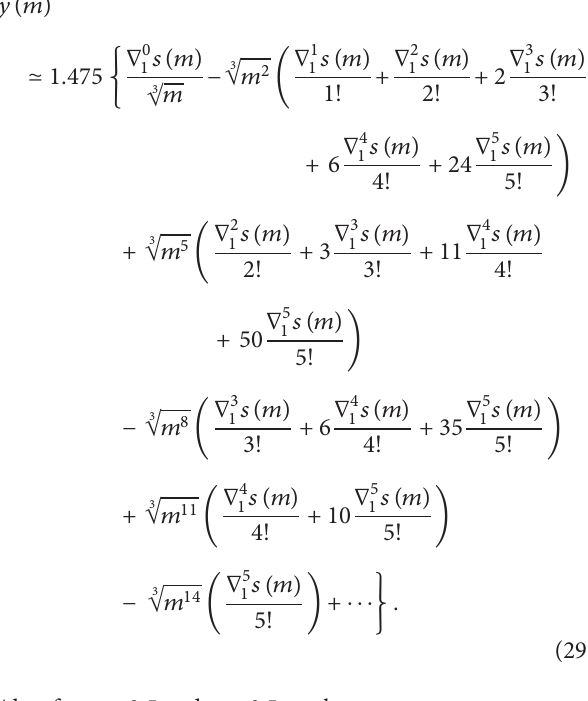
Figure 2: The outcome of the fractional signal when 𝛼 = 0.75 , 𝑇 = 1/25